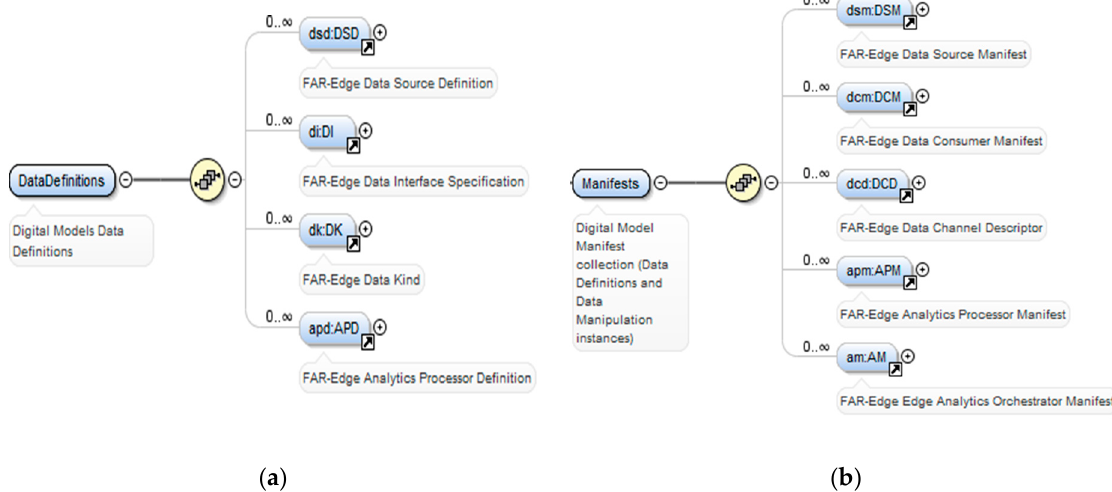
Figure 5. Data Definitions and Manifests Subschemas. ( a ) Factory Data Definitions and Manifests Subschemas ( b ) metadata Definitions and Manifests